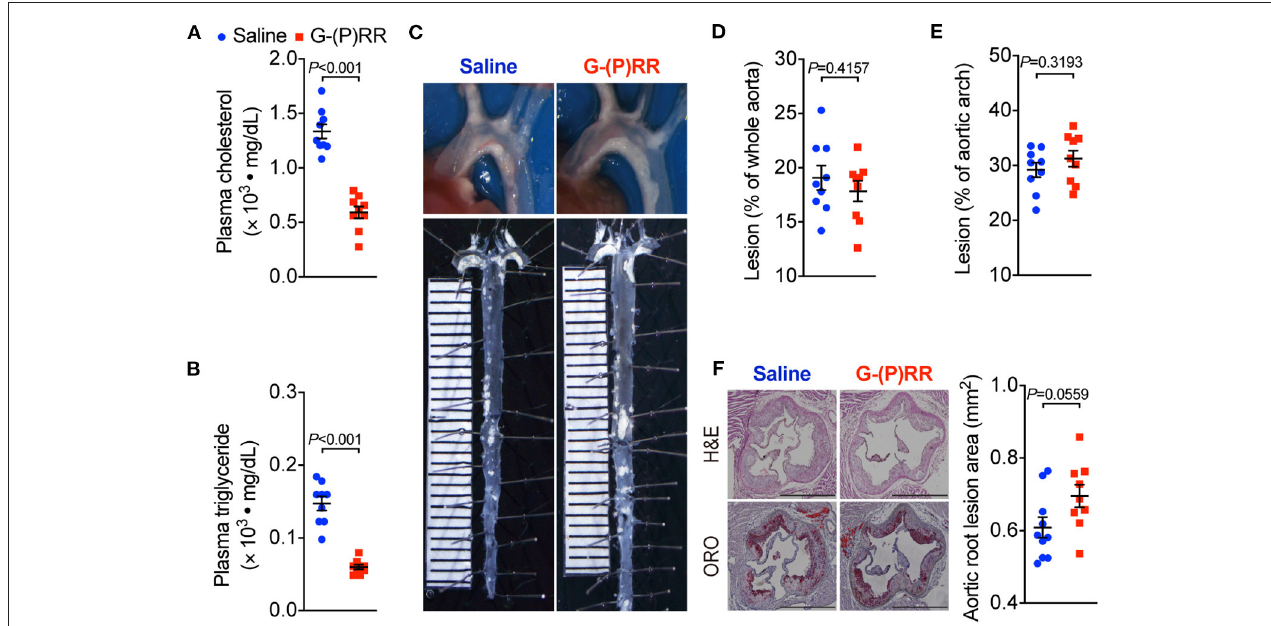
FIGURE 2 | (P)RR G-ASOs reduced plasma lipid concentrations, but not atherosclerosis in ApoE − / − mice. Eight-week-old ApoE − / − mice were administered with either saline (blue) or (P)RR G-ASO (red) and fed a WTD for 16 weeks. N = 9 per group. Plasma cholesterol (A) and triglycerides concentrations (B) . Representative images of aortic arch and en face whole aorta (C) . Quantification of lesions in whole aorta (D) or aortic arch region (E) . Representative images showing H&E and ORO-stained sectioned aortic root and quantification of lesion size in aortic root (F) . Bar = 1,000 µ